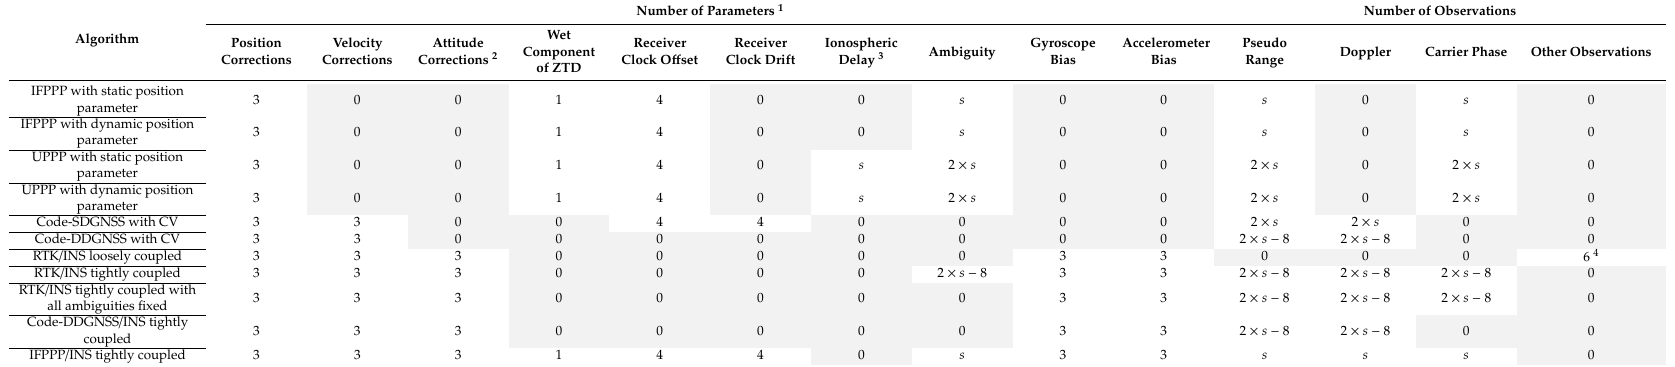
Table 8. Compositions and numbers of parameters and observations in GNSS algorithms. ZTD, zenith troposphere delay. IFPPP: ionosphere-free precise point positioning, SDGNSS: single-di ff erence GNSS, RTK: real-time kinematic, UPPP uncombined precise point